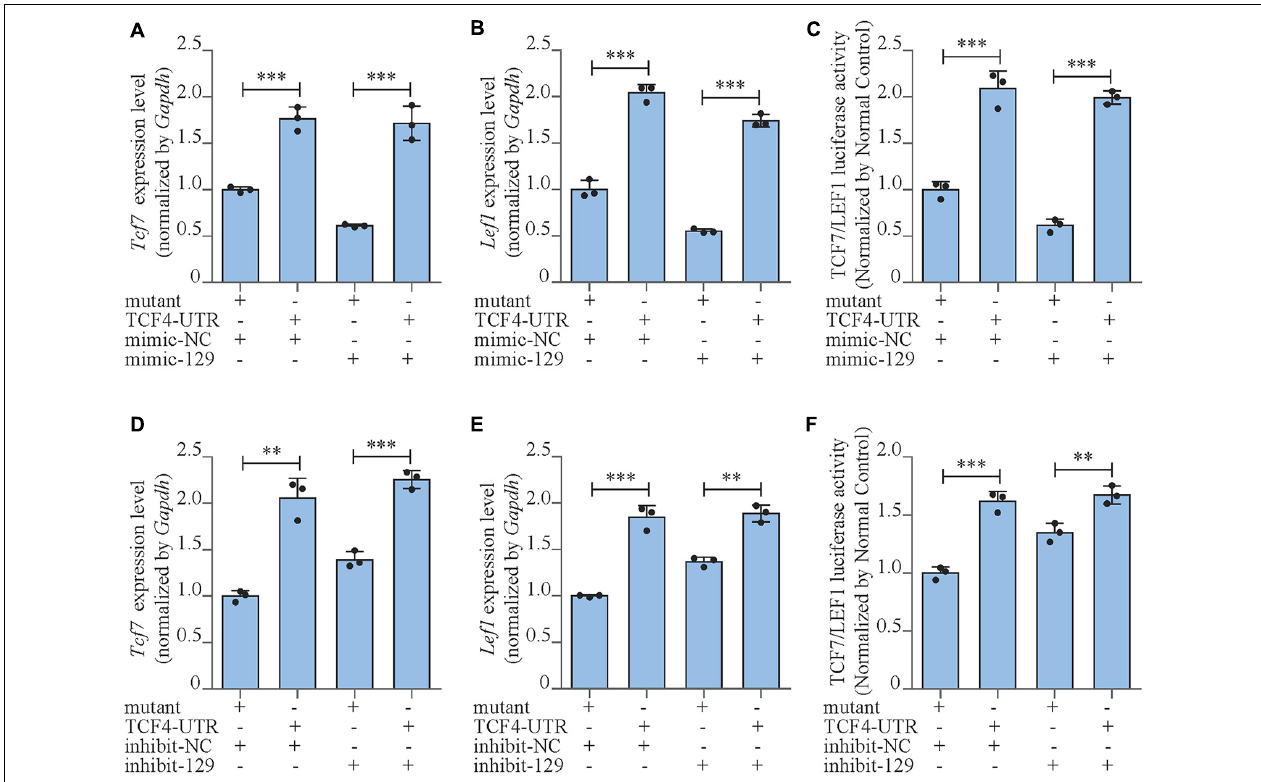
FIGURE 5 | miR-129-5p inhibited Wnt/ β -catenin downstream transcript factors via targeting Tcf4. (A,B) Tcf7 and Lef1 expression levels of MC3T3-E1 cells treated with Tcf4– 3 (cid:48) UTR plasmid and mimic-129-5p, as detected by reverse transcriptase-polymerase chain reaction (RT-PCR; mean ± SD, ∗∗∗ P < 0.001). Mutant/TCF4-UTR: expression plasmid containing mutant/wild-type miR-129-5p binding site sequence of Tcf4– 3 (cid:48) UTR. (C) TCF7/LEF1 activities of MC3T3-E1 cells treated with Tcf4– 3 (cid:48) UTR plasmid and mimic-129-5p, as detected by luciferase reporter assay (mean ± SD, ∗∗∗ P < 0.001). (D,E) Tcf7 and Lef1 expression levels of MC3T3-E1 cells treated with Tcf4– 3 (cid:48) UTR plasmid and inhibitor-129-5p, as detected by RT-PCR (mean ± SD, ∗∗ P < 0.01, ∗∗∗ P < 0.001). (F) TCF7/LEF1 activities of MC3T3-E1 cells treated with Tcf4– 3 (cid:48) UTR plasmid and inhibitor-129-5p, as detected by luciferase reporter assay (mean ± SD, ∗∗ P < 0.01, ∗∗∗ P <